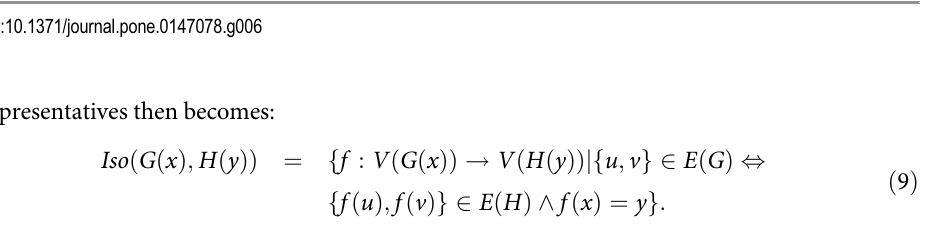
Fig 6. Orbit representative 44. The central vertex is marked and called vertex 0, to indicate that it cannot be interchanged with any other vertex.